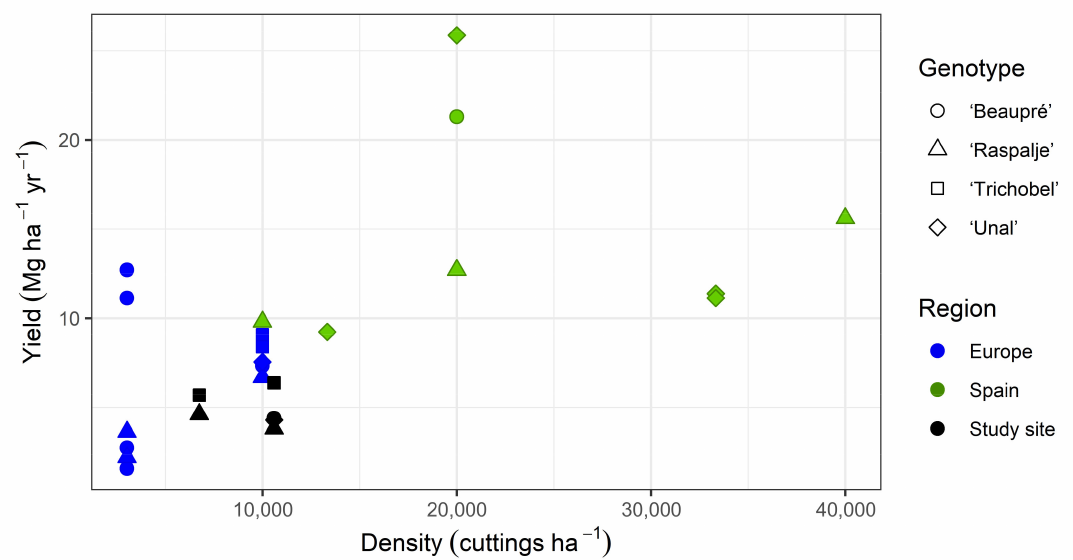
Figure 2. Comparison of yield–density relationship for the most productive clones in the present study and the values cited for these clones in other zones of Spain and Europe gathered in Oliveira, et al. [1], which correspond to the following references showing only plantations between 3 and 4 years old [22–32]. Non-irrigated plantations are represented in dark colors, while irrigated plantations are represented in light